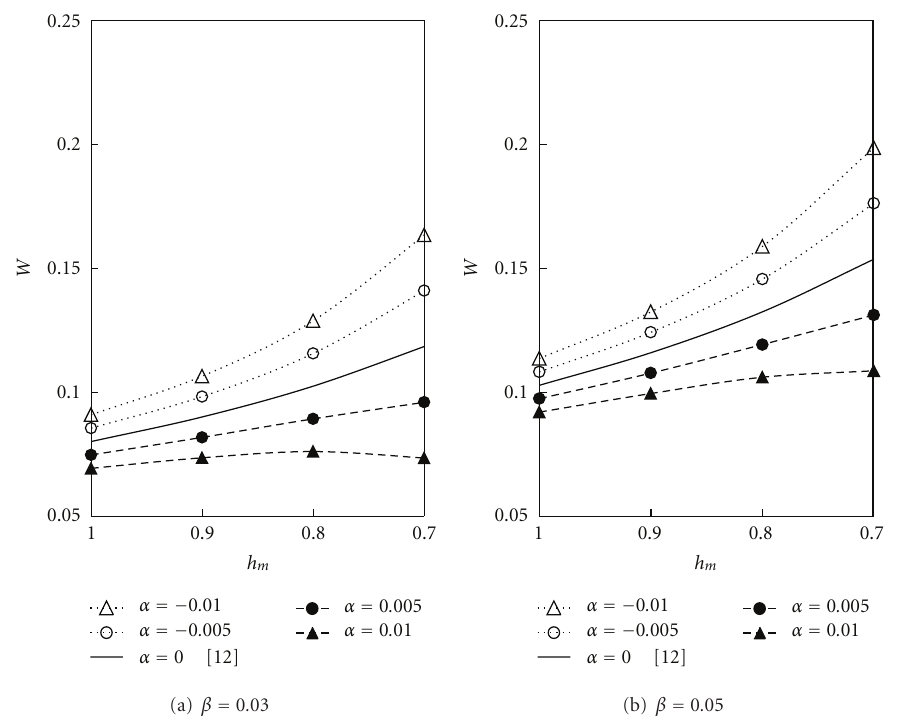
Figure 4: Variation of the dimensionless load capacity with respect to the dimensionless minimum film thickness h m for values of parameter α